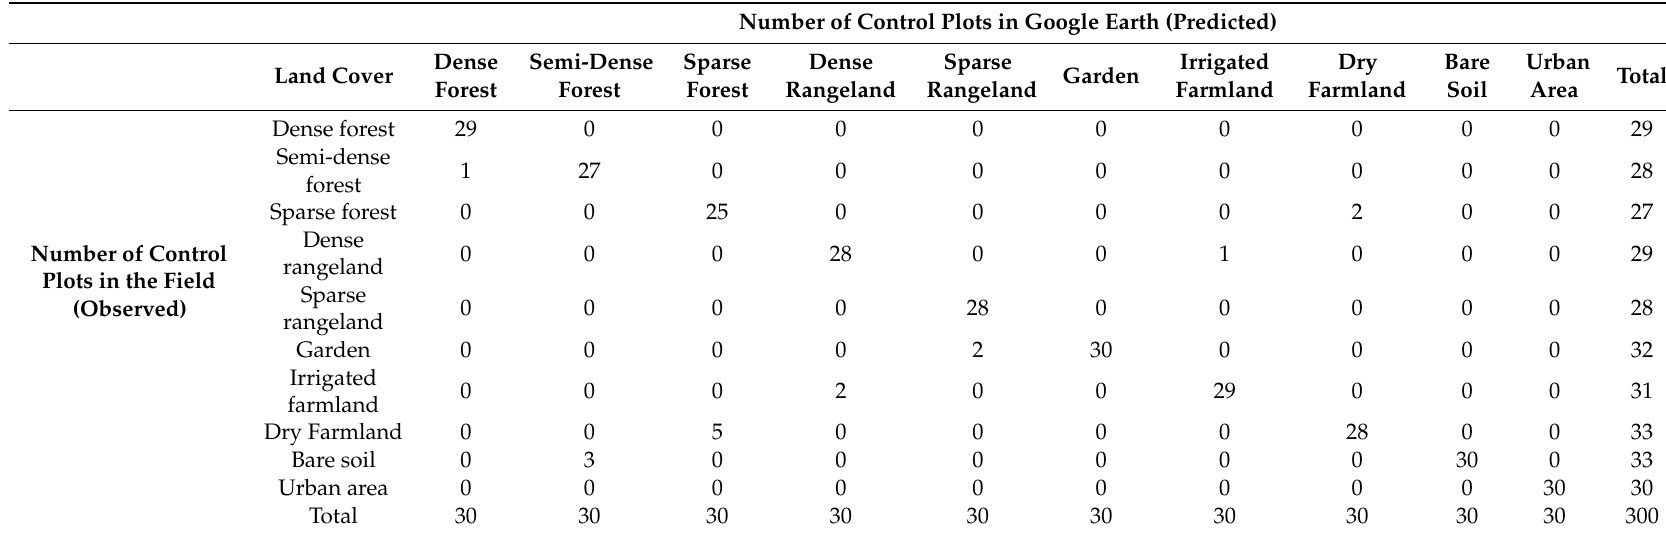
Table 2. The confusion matrix of comparison of the control plots in the Google Earth (predicted) and in the field (observed). Number of Control Plots in Google Earth